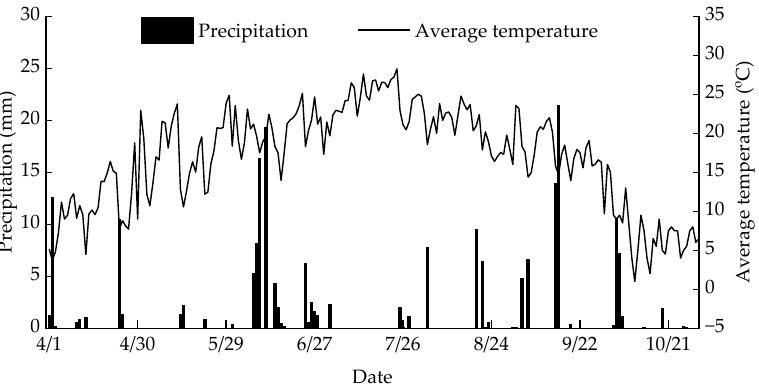
Figure 1. Distribution of daily precipitation and average temperature during the experiment.